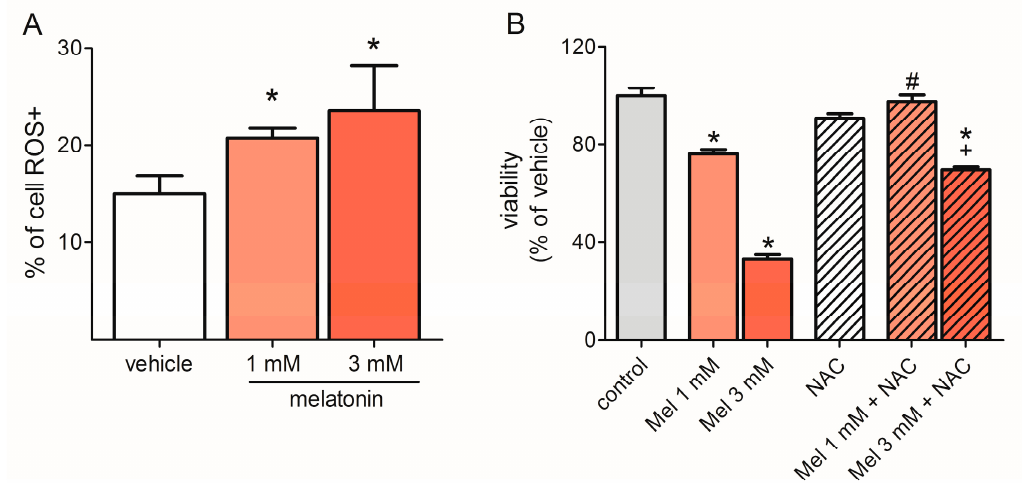
Figure 4. Melatonin increases reactive oxygen species (ROS) production—( A ) U87MG cells were incubated with melatonin (1 mM or 3 mM) for 72 h, and the medium was exchanged every 24 h. ROS